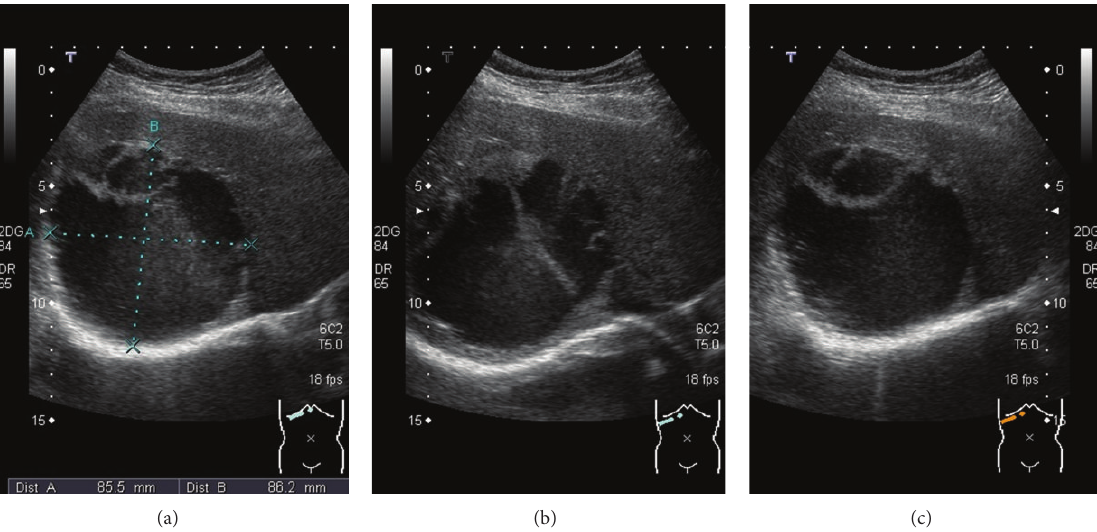
Figure 2: Abdominal ultrasonography performed in January 2012 reveals multiple cysts in both hepatic lobes. The cystic lesion occupying the entire right hepatic lobe shows irregular septal structures and nodules.